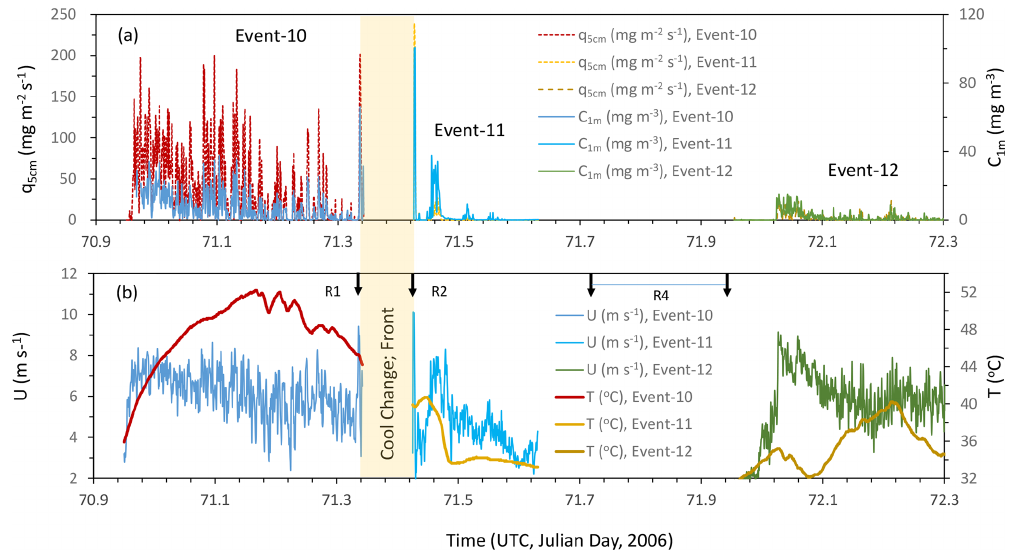
Figure 5. (a) One-minute averaged saltation flux at 0.05m, q 5 cm , and dust concentration at 1m, C 1 m , for Event-10, Event-11 and Event-12; (b) same as (a) but for wind speed at 0.53m above ground, U , and air temperature at 0.66m, T . The cool change is marked and the three rain events sensed by the rain sensor are marked as R1, R2 and R4 using the black arrows.